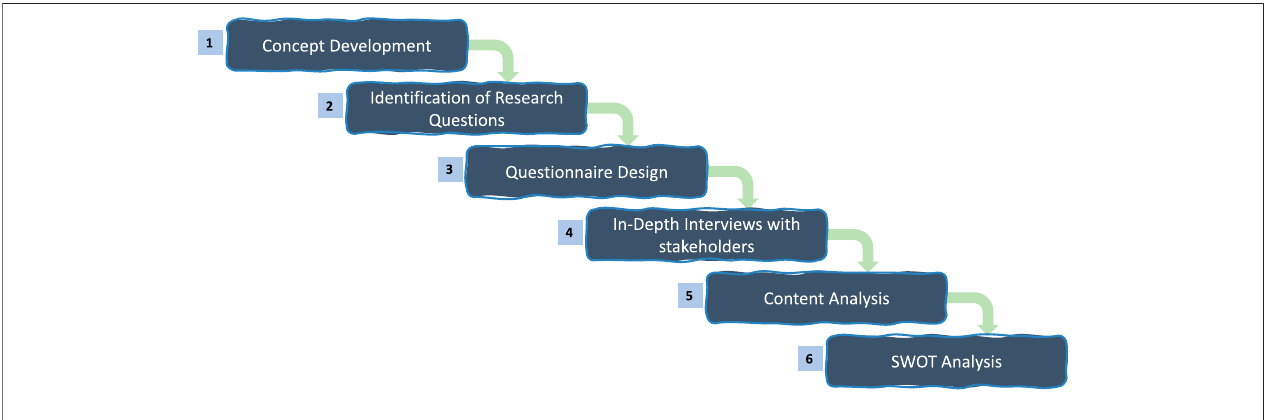
FIGURE 3 | Research methodology of the study. Source: Own Elaboration.